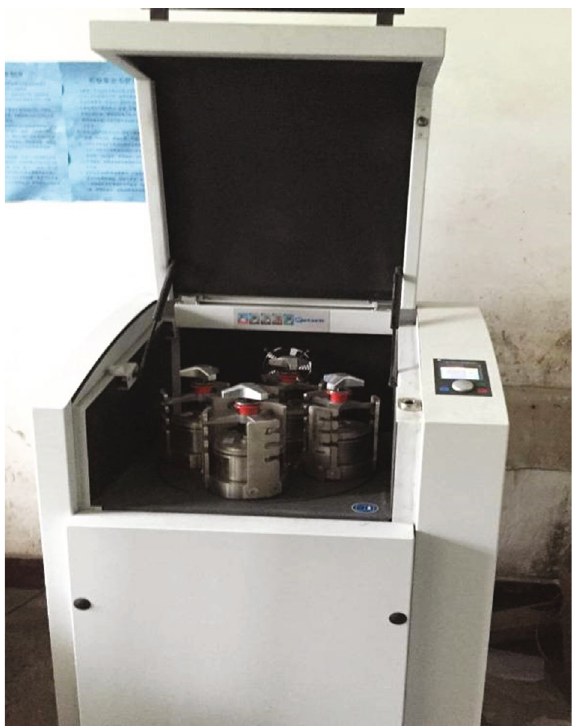
Figure 3: Planetary ball mill with four